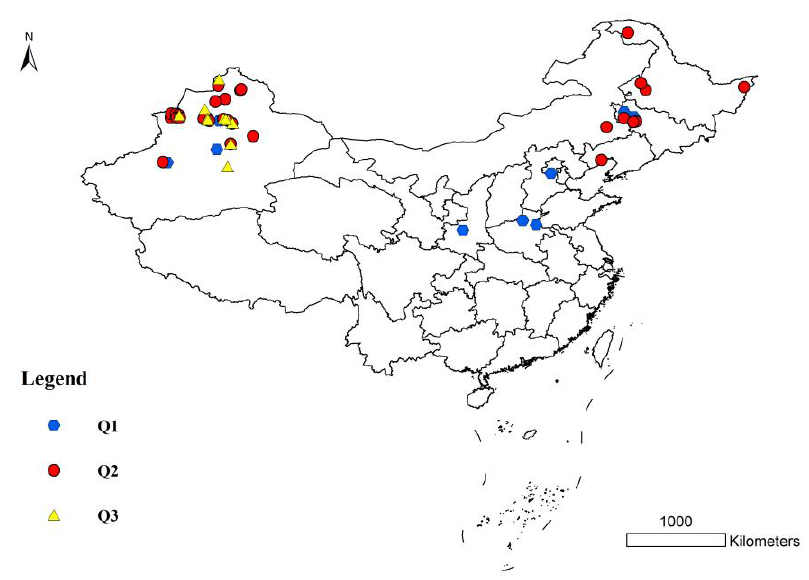
Figure 3. Distribution of S. nigrum used in this study and the different ancestors.